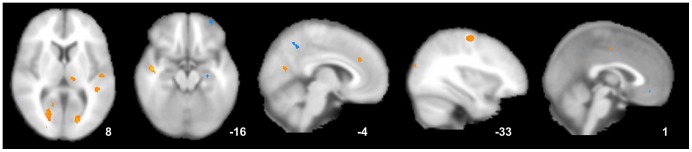
Direct comparison of the ReHo changes between the active and inactive group.The active acupoint group showed higher ReHo in the thalamus, ACC, superior temporal gyrus, SMA and lower ReHo in the hippocampus, middle frontal gyrus, and middle temporal cortex than the inactive group (P<0.001, uncorrected).